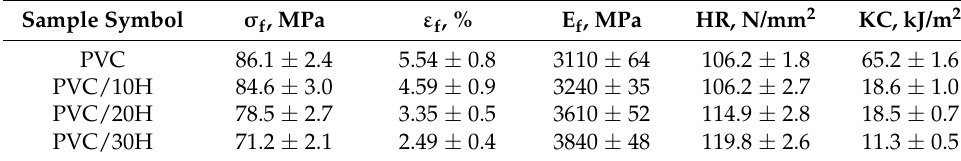
Table 7. Flexural, hardness and impact test results of PVC and PVC/H composites. Sample